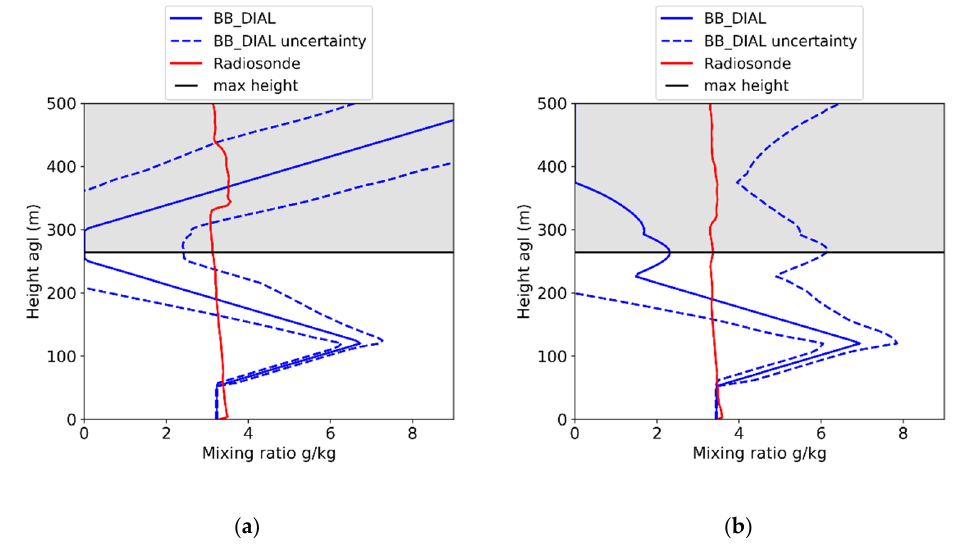
Figure 22. ( a ) radiosonde at 4:45 and BB_DIAL data for the fog case on 4 February 2019 at Lindenberg, ( b ) the same for 10:45 (Data provided by Dr Knist Christine